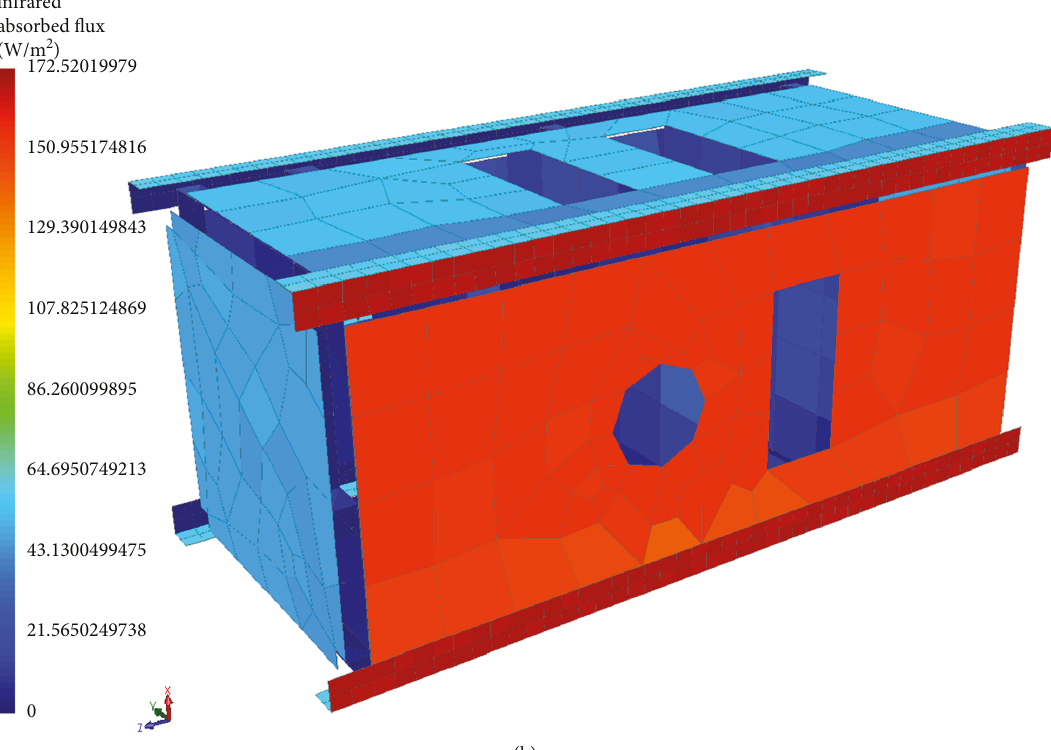
Figure 12: (a) Mean absorbed solar fl ux (872.66W/m 2 ) and (b) mean absorbed Earth IR fl ux (172.52 W/m 2